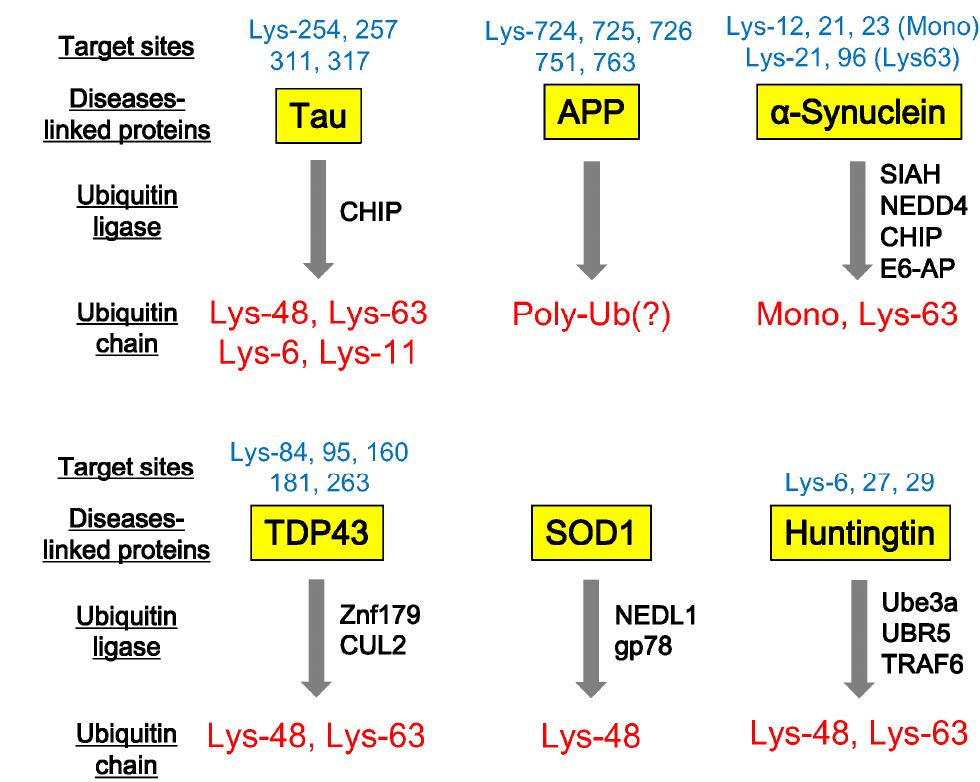
Figure 2. Ubiquitination of neurodegenerative disease-associated proteins. Neurodegenerative disease-associated proteins, such as Tau, APP ( β -amyloid precursor protein), α -synuclein, TDP43, SOD1, and Huntingtin are ubiquitinated at individual target sites. Specific ubiquitin ligases involved in this ubiquitination and the pattern of ubiquitin chains can be identified by various biochemical studies.